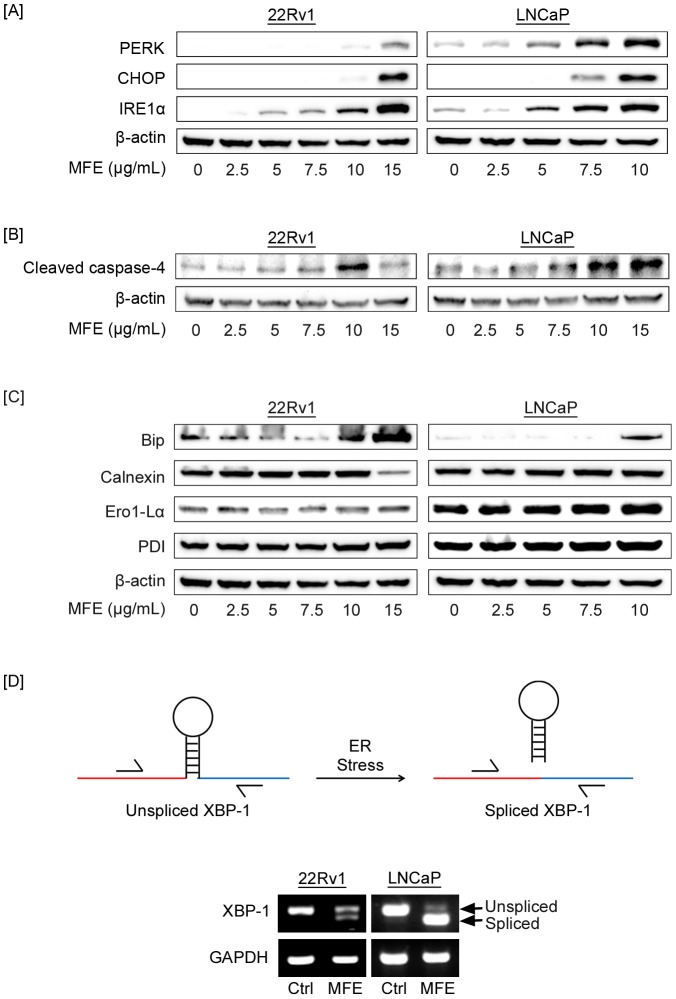
Mangosteen fruit extract (MFE) up-regulated endoplasmic reticulum (ER) stress proteins and chaperones in prostate cancer cells.22Rv1 and LNCaP cells were treated with increasing doses of MFE or α-Mangostin for 24 hr. Cell lysates were prepared and subjected to western blot for detecting the expression of critical ER stress proteins. [A], Expression of ER stress proteins in increasing doses of MFE-treated 22Rv1 and LNCaP cells. [B], Cleaved caspase-4 levels in increasing doses of MFE-treated 22Rv1 and LNCaP cells. [C], Expression of multiple ER chaperones in increasing doses of MFE-treated 22Rv1 and LNCaP cells. Beta-actin was used as a loading control. These results are representatives from three independent experiments. [D], Upper panel, schematic diagram of XBP-1 splicing during ER stress. Lower panel, agarose gel pictures of RT-PCR products. 22Rv1 and LNCaP cells were treated with 15 µg/ml MFE for 24 hr. Total RNA was extracted and subjected to RT-PCR. XBP-1primers spanning the spliced sequence were used. RT-PCR products were run on a 2% agarose gel. GAPDH was used as a control.